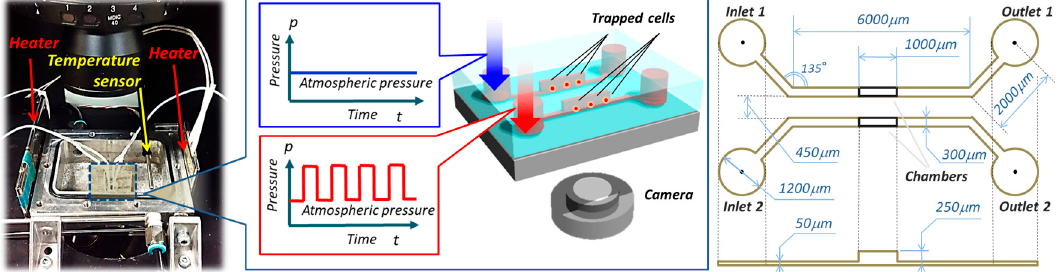
Figure 2. An overview of the experimental system. From left to right are the on-microscope incubation system, design of on-chip cell incubator and its dimensions, respectively. The system is mainly composed of two parallel chambers for simultaneously observation of cell culture with and without Periodic hydrostatic